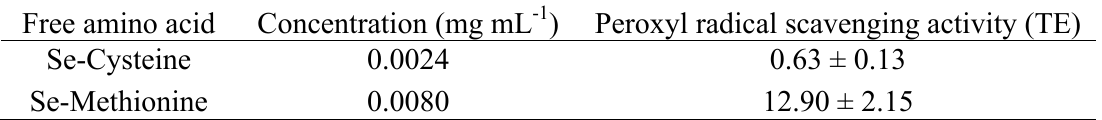
Table 5. Antioxidant capacity of pure selenoamino acids commercial available at the concentrations present in P. arborescens subsp. maderensis extract. Values are the mean of three independent replicates ±